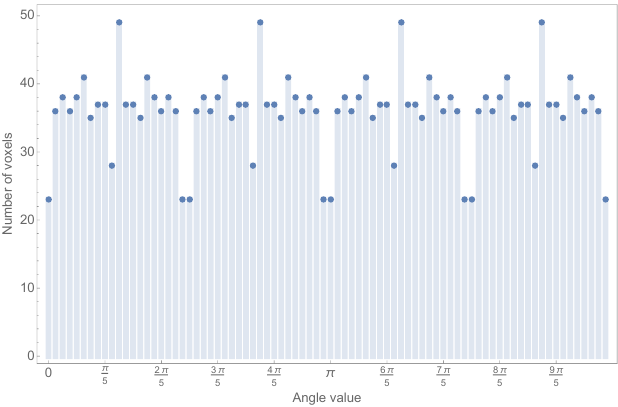
Figure 1. Histogram of angle values in a 60 × 60